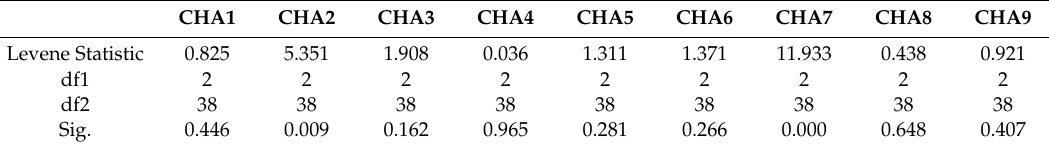
Table 5. Test for homogeneity of variances (based on means).